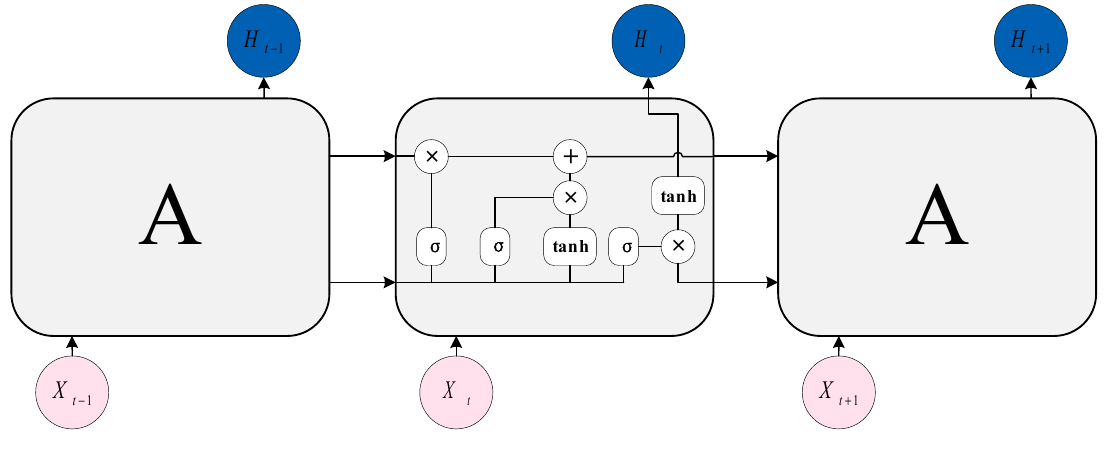
Figure 16. The structure of LSTM.